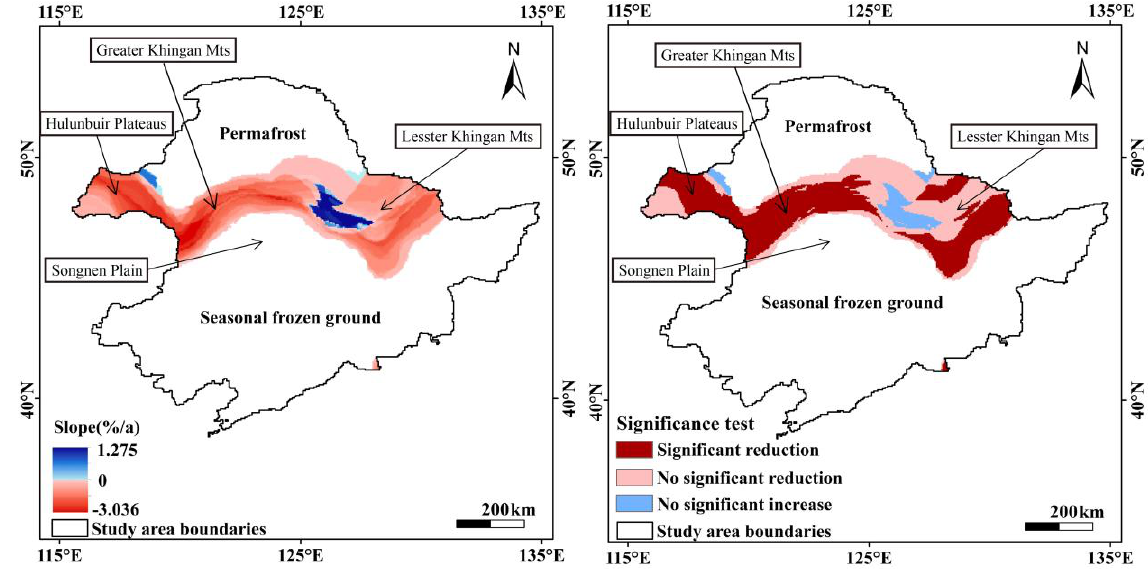
Figure 5. ( a ) The variation trend of permafrost in northeast China and ( b ) the results of an applied significance test.